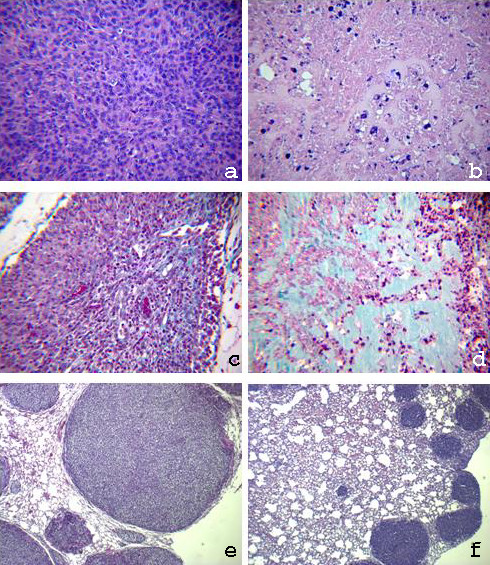
Sorafenib reduces tumour mass in OS xenografts in SCID mice. Histological sections derived from sorafenib untreated (a) and treated (b) xenografts stained with Hematoxylin and Eosin show massive necrosis and reduced cellularity. Sorafenib reduces blood vessel number. 40× magnification on Masson's trichromic staining of sorafenib untreated (c) and treated (d) xenografts. Sorafenib reduces lung OS foci. Pictures show representative examples (10× magnification) of OS foci in lung sections of untreated (e) and sorafenib-treated mice (f).